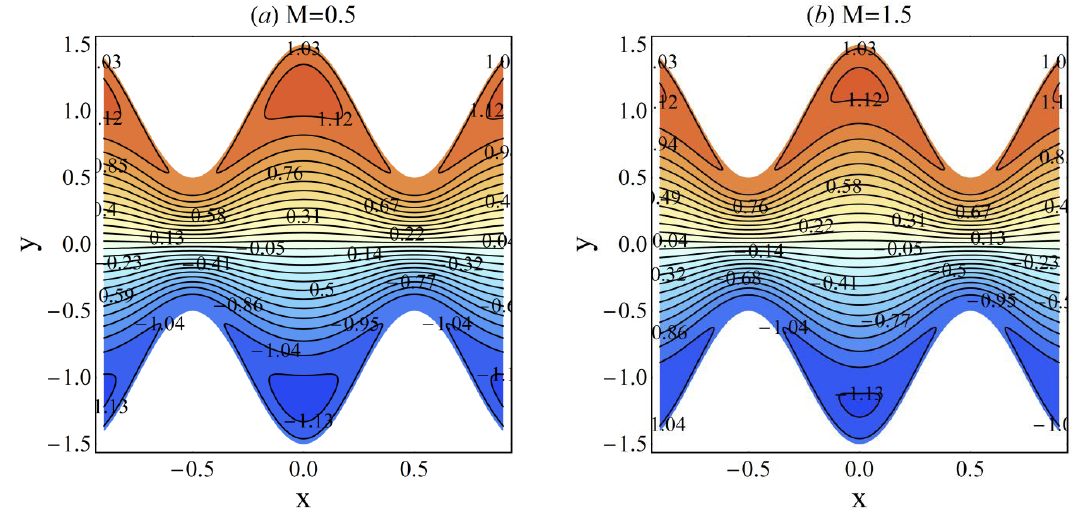
Figure 19. Streamlines at different M when Fr = 1, n = ε = 0.2, α = 0.1, We 2 = 0.01, β = 0.5, ξ = π/3, Fr = 0.5 : (a) M = 0.5 and (b) M = 1.5.